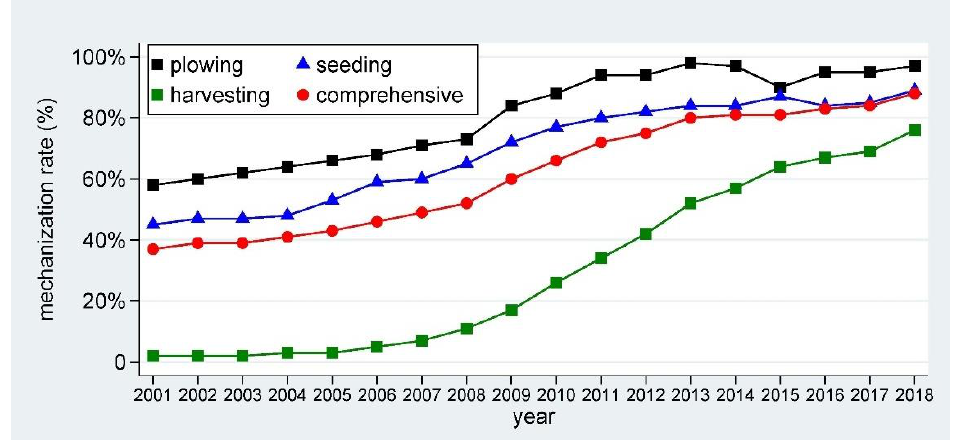
Figure 1. Mechanization rate of maize production in China, 2001–2018. Data source: China Agricultural Machinery Industry Yearbook [6]. Note: mechanical plowing rate—areas of mechanical plowing (hm 2 )/areas that are supposed to be plowed (hm 2 ); mechanical seeding rate—areas of mechanical seeding (hm 2 )/total areas of sowing (hm 2 ); mechanical harvesting rate—areas of mechanical harvesting (hm 2 )/total areas of sowing (hm 2 ); comprehensive mechanization rate—0.4×mechanical plowing